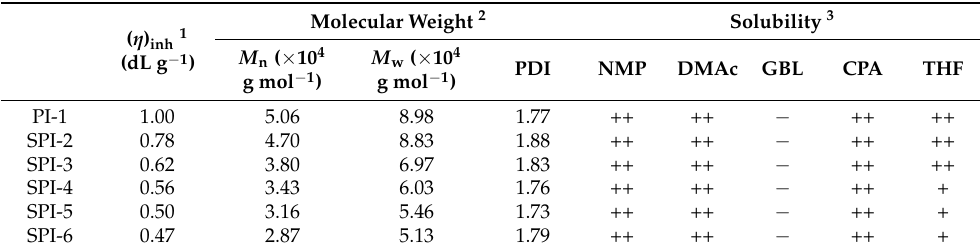
Table 2. Inherent viscosities, molecular weights, and solubility of PI resins. ( η ) inh 1 (dL g − 1 )